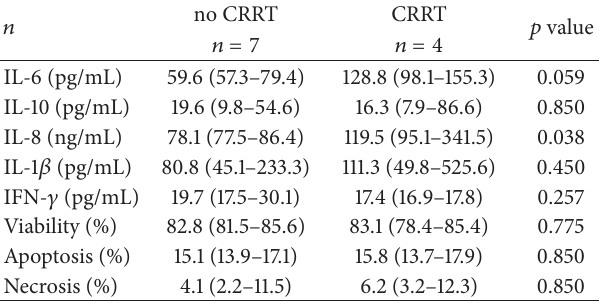
Table 4: Differences in immune-mediated molecules and in vitro viability rates in patients who have undergone CRRTorwho did